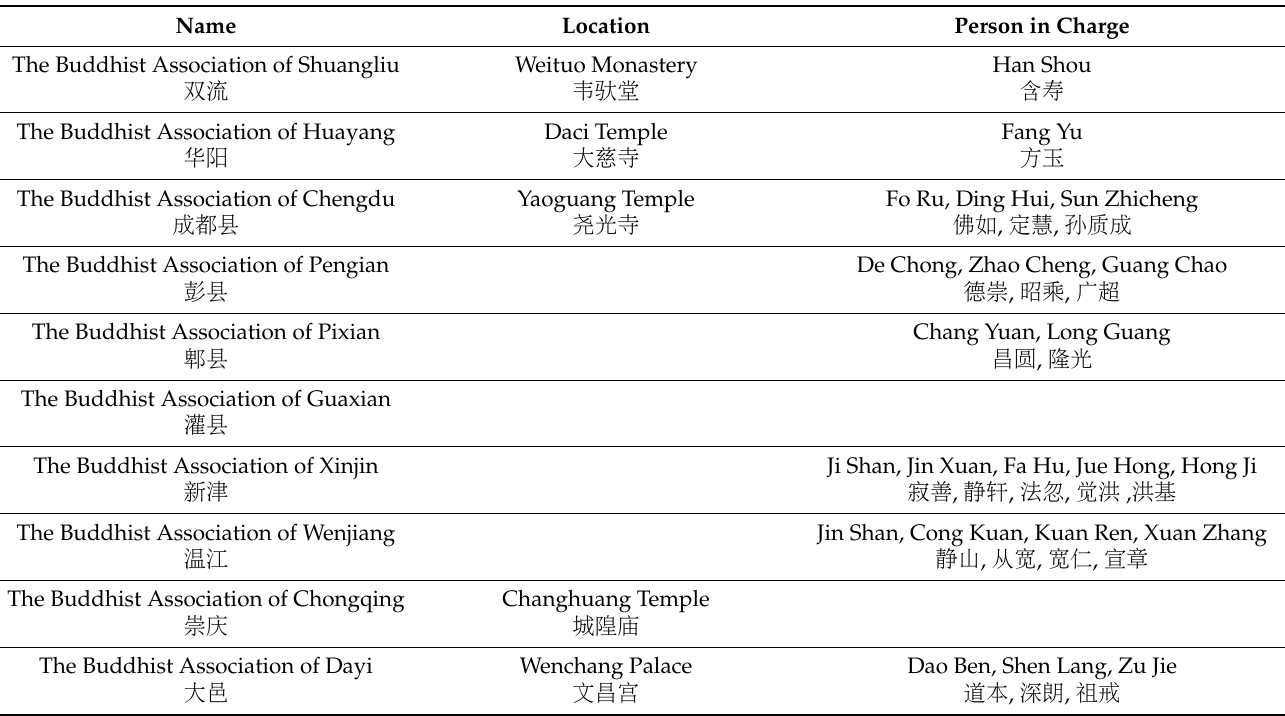
Table 1. List of the Buddhist associations in Chengdu before 1949, including locations and persons in charge.